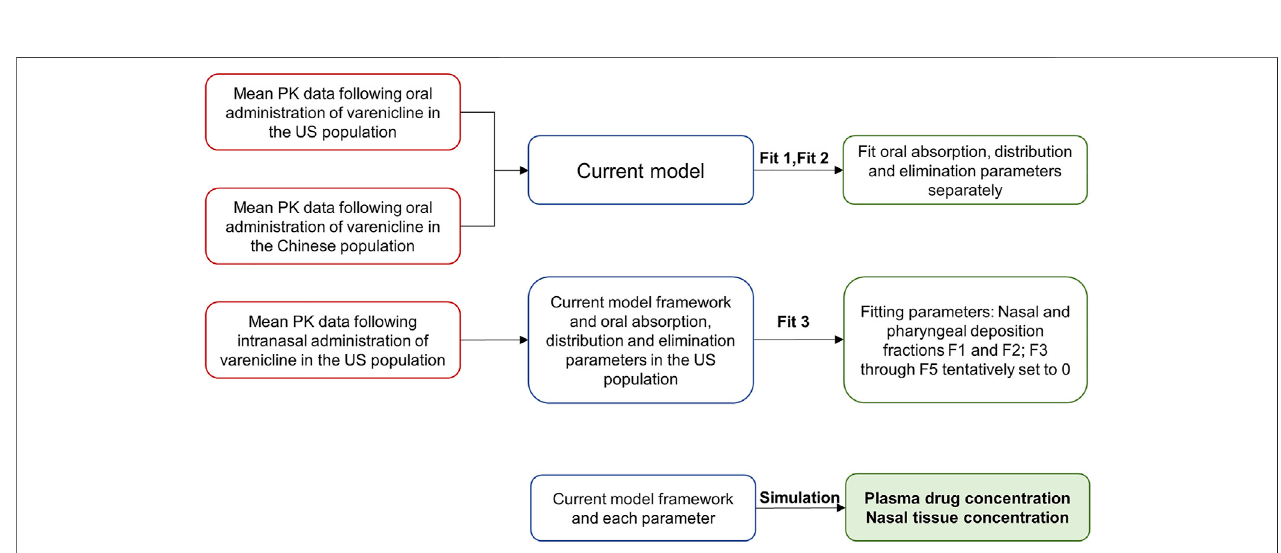
FIGURE 2 | Simulation